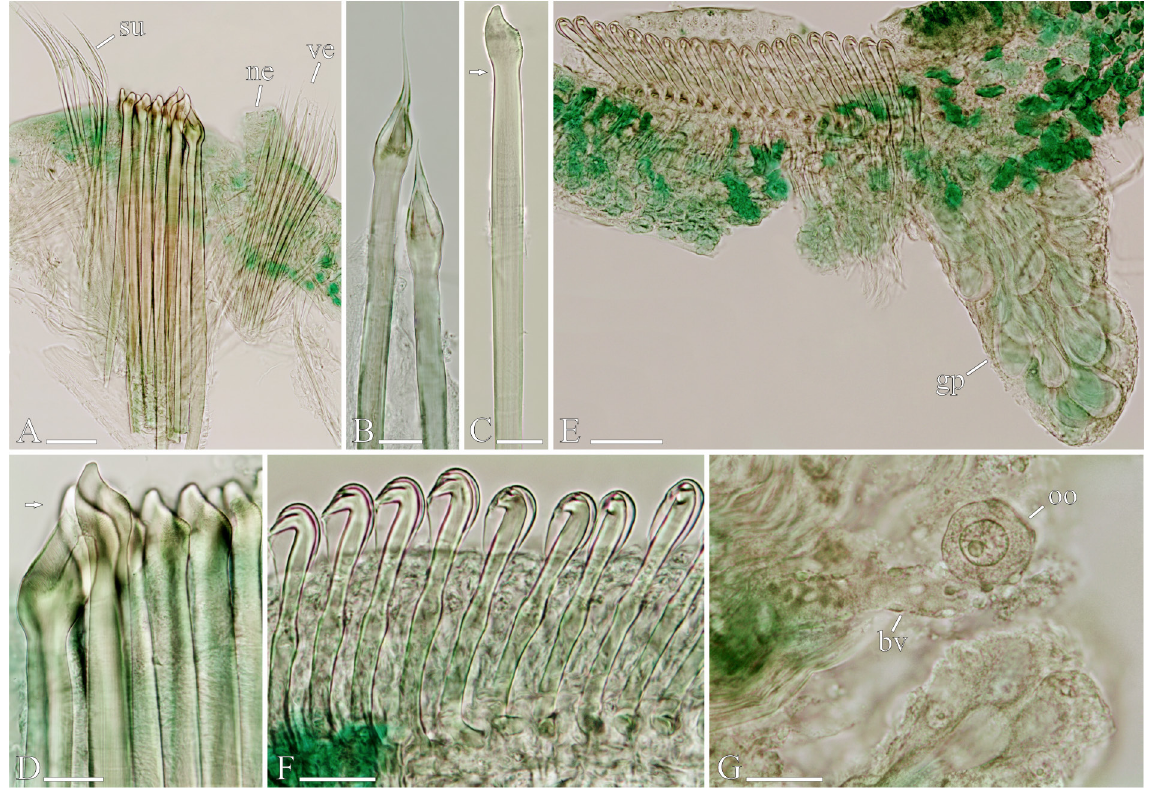
Fig. 19. Chaetal and gamete morphology of Pseudopolydora melanopalpa sp. nov. (formalin-fixed and stained with MG specimens, MIMB 40909). A . Parapodia of chaetiger 5. B . Anterior-row spines of chaetiger 5, view from the outside of the U-shaped spine row. C . Posterior-row falcate spine of chaetiger 5, lateral view. D . Notopodial spines of chaetiger 5, lateral view. E . Neuropodium of chaetiger 10, showing glandular pouch associated with a series of hooded hooks. F . Hooded hooks from middle neuropodium. G . Small previtellogenic oocyte on a genital blood vessel. Abbreviations: arrows showing the direction towards the inside of the U-shaped row of spines; bv = genital blood vessel; gp = glandular pouch; ne = neuropodial postchaetal lamella; oo = oocyte; su = dorsal superior capillary chaetae; ve = ventral capillary chaetae. Scale bars: A, E = 50 µm; B–D, F–G = 20